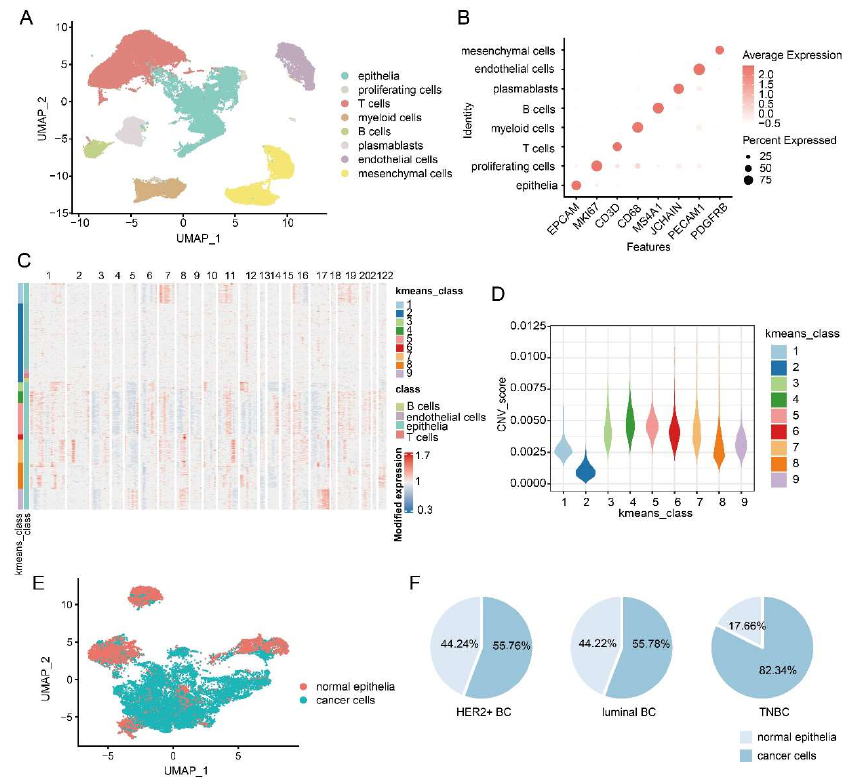
Figure 2. Identification of tumor cells from epithelia. ( A ) Uniform manifold approximation and projection (UMAP) cluster plot of different BC cell types. ( B ) Expression levels of cellular markers corresponding to different BC cell types. ( C ) Unsupervised clustering of inferred large-scale copy number variations (CNVs) to identify cancer cells from epithelia cells. Epithelial cells and reference cells (B cells, T cells and endothelial cells) are in the y-axis and chromosomal regions in the x-axis. ( D ) Violin plot showing the differences of CNVs scores among 9 clusters. ( E ) UMAP cluster plot showing the distribution of normal epithelial cells and cancer cells. ( F ) The proportion of cancer cells and normal epithelial cells of the three subtypes of BC.